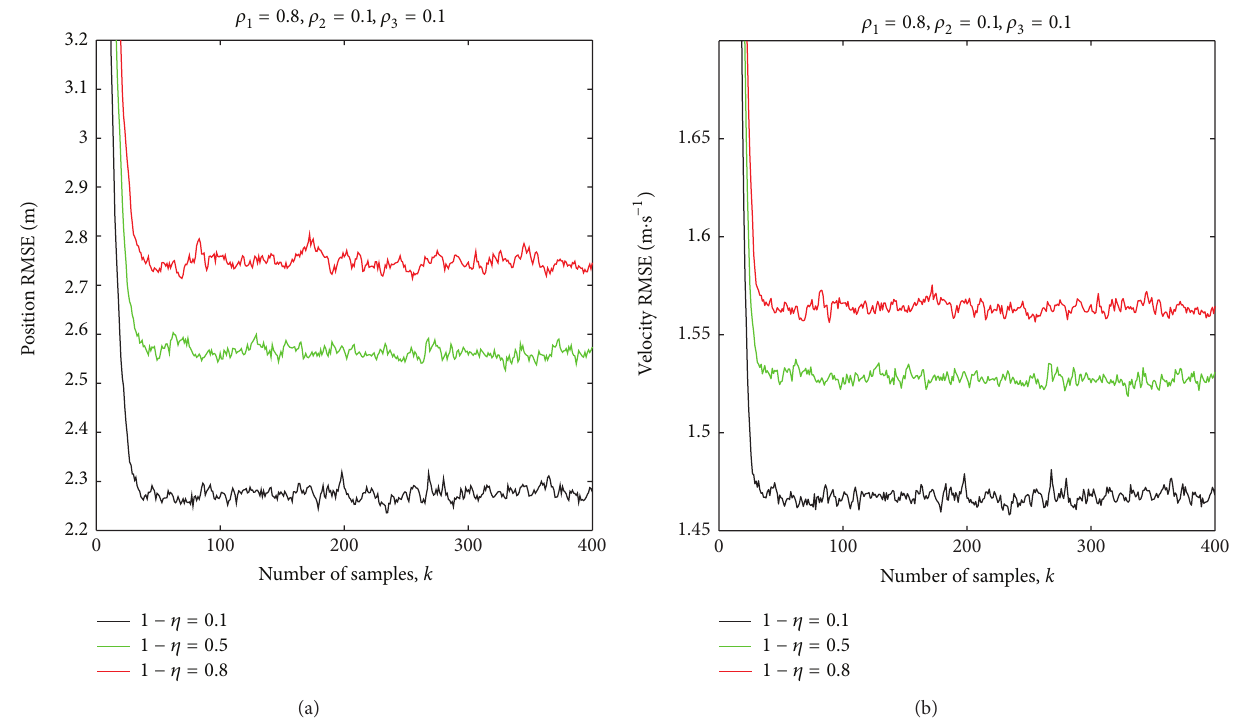
Figure 4: Comparison of the RMSEs for the proposed algorithm with different 𝜌 𝑞 (𝑞 = 1, 2, 3) : (a) position RMSE; (b) velocity